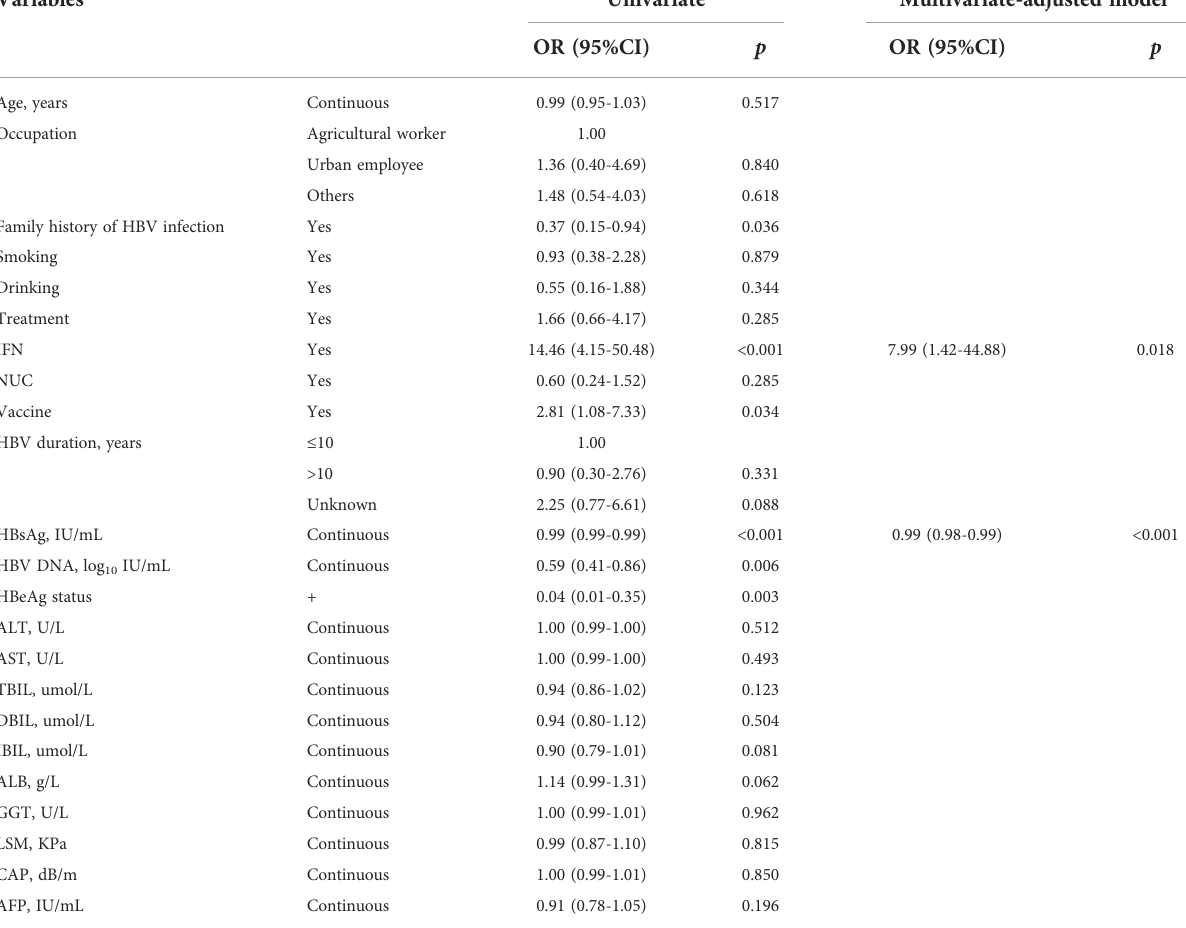
TABLE 2 Logistic regression analysis of general